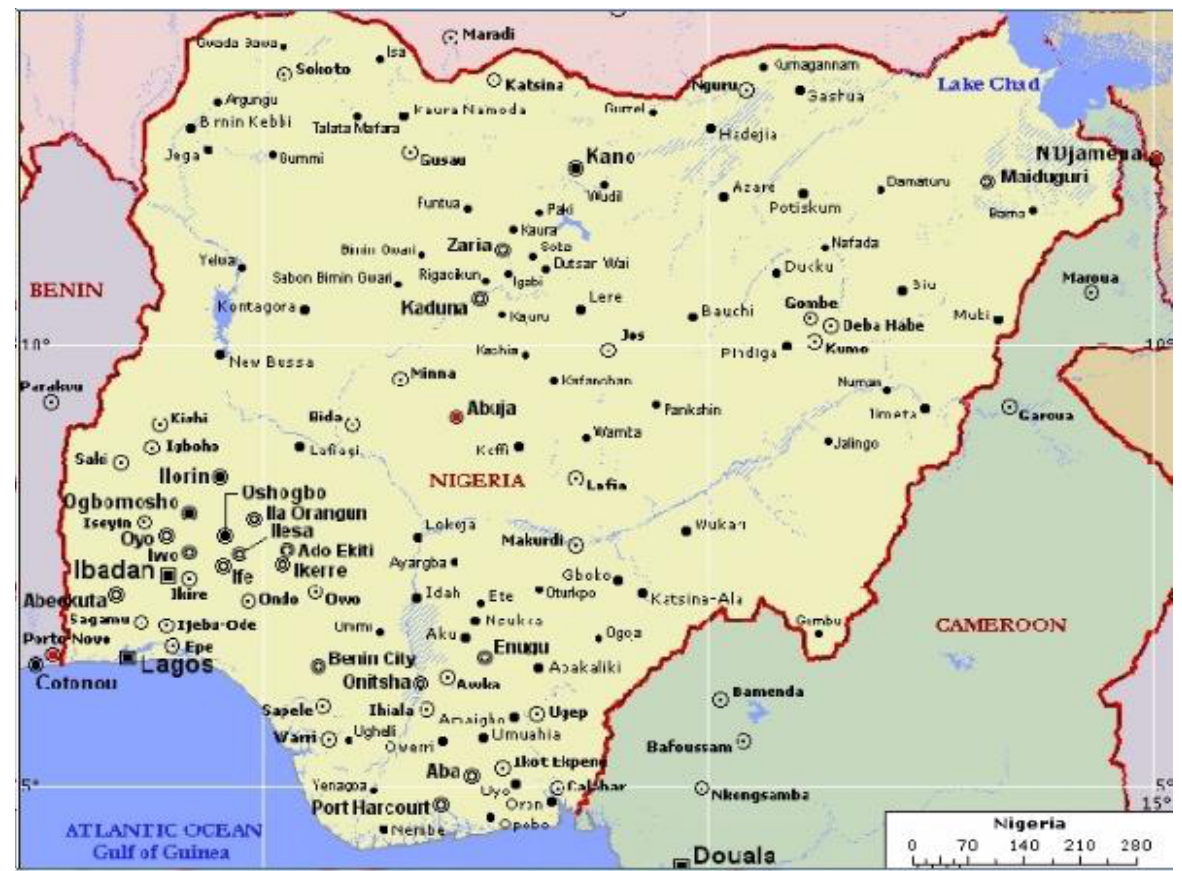
Figure 1: Map of Nigeria showing the Origin and Destination (OD) of Travel routes explored in the